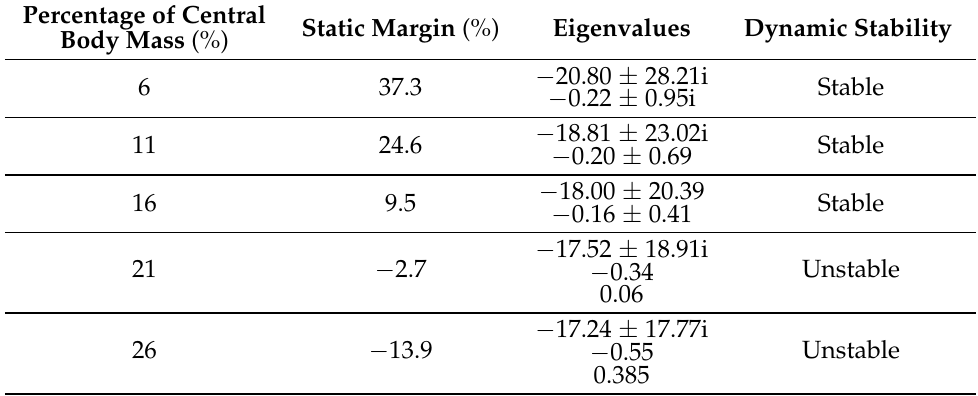
Table 4. Effect of abdominal mass as a percentage of central body mass on longitudinal stability. Percentage of Central Body Mass